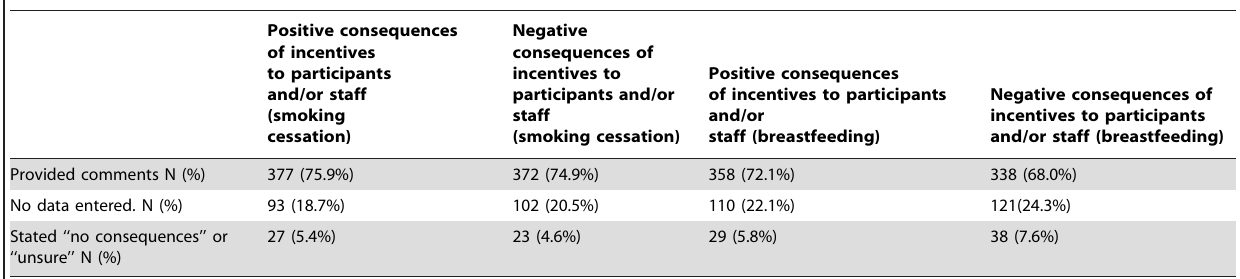
Table 10. Response rates to free text questions in the professional survey (n=497).